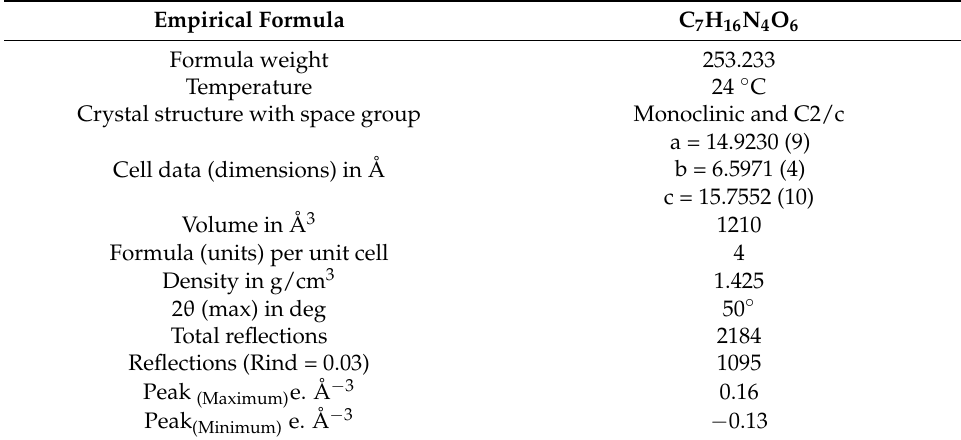
Figure 2. Molecular structure for UGA (2/1). Table 1. Determined crystal data of UGA [12].